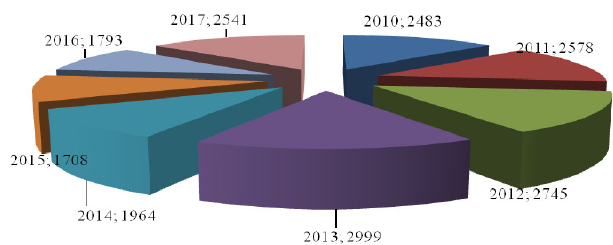
Fig. 3. Catching the aquatic bioresources in the inland water bodies of the Mykolaiv